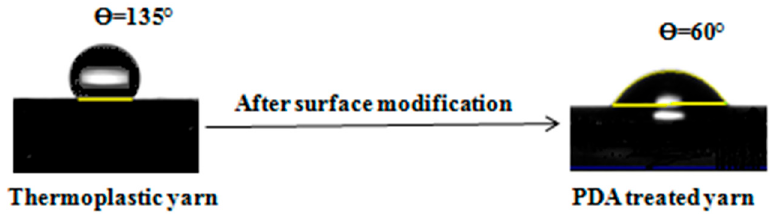
Figure 6. The images of water contact angle of untreated and PDA treated thermoplastic yarns.